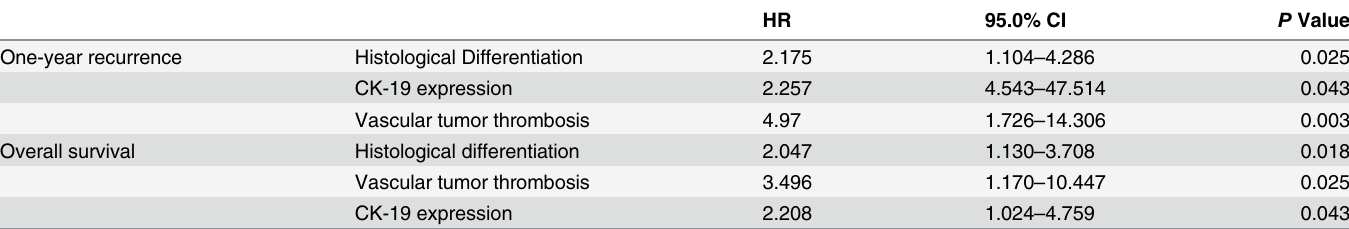
Table 6. Cox regression